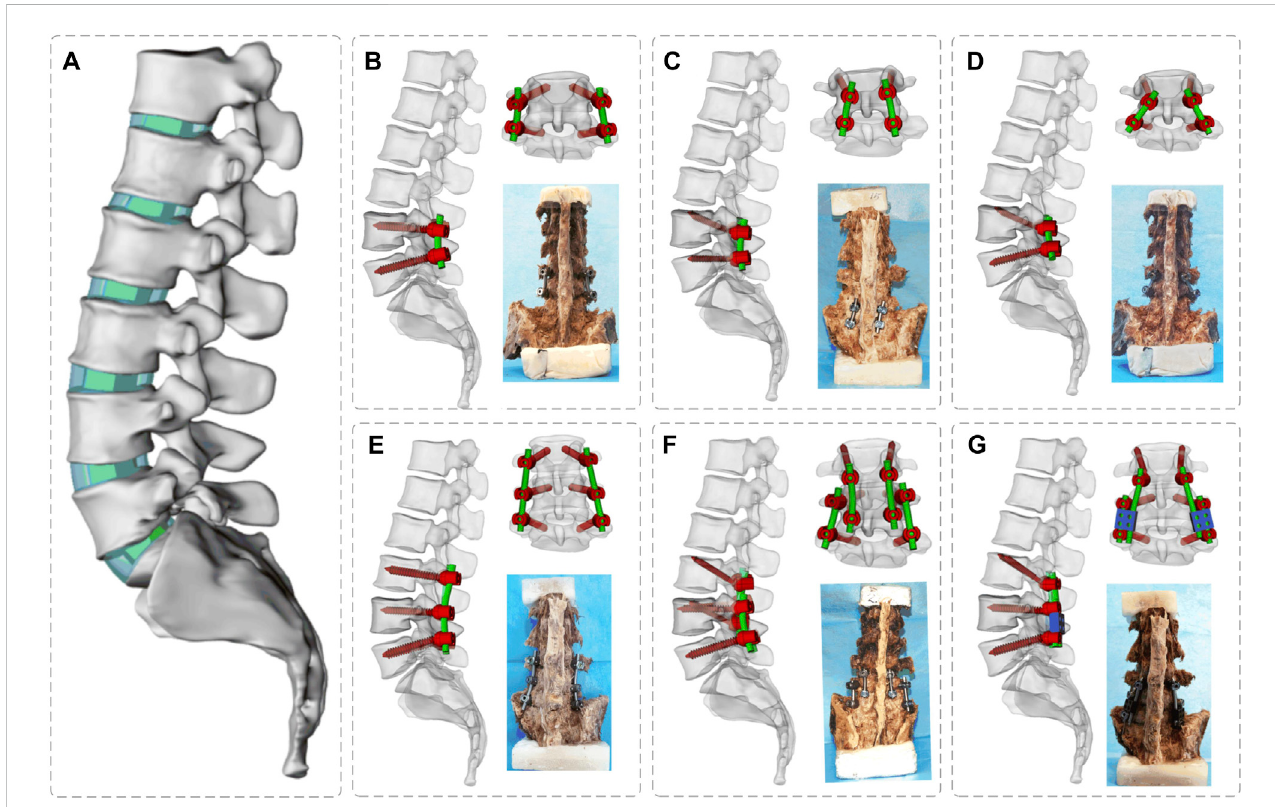
FIGURE 2 Three-dimensional simulation models and spine specimen models for posterior internal fi xation of T12-S segment lumbar spine. (A) Intact model, (B) L45 PS model, (C) L45CBT model, (D) L4 CBT/L5 PS model, (E) L345 PS model, (F) L34CBT/L45PS model, and (G) L3 CBT-L45 PS